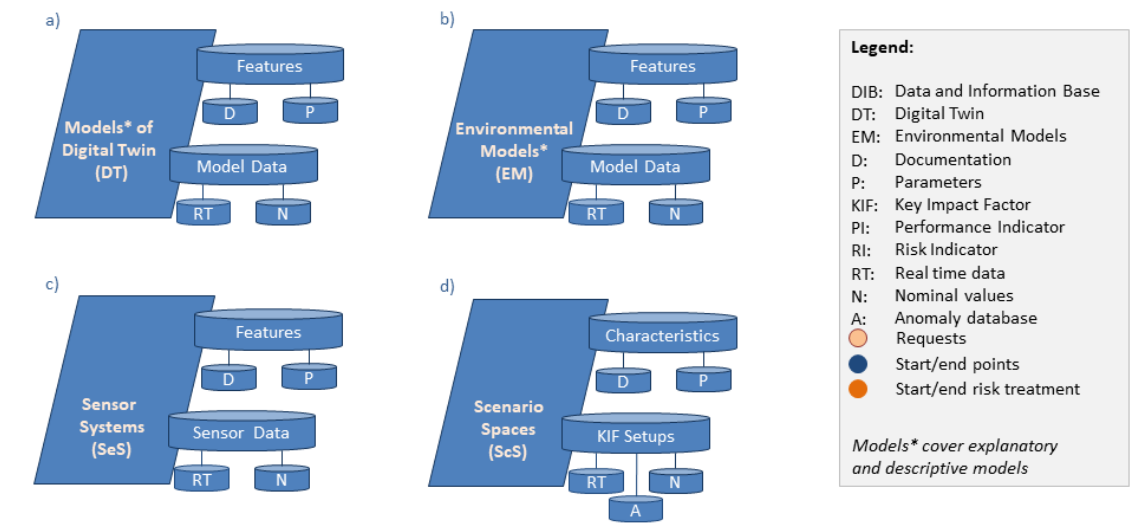
Figure 1. Data and information base (DIB) of the proposed resilience management: ( a ) the digital twin models, ( b ) environmental models, ( c ) sensor systems, and ( d ) scenario spaces.